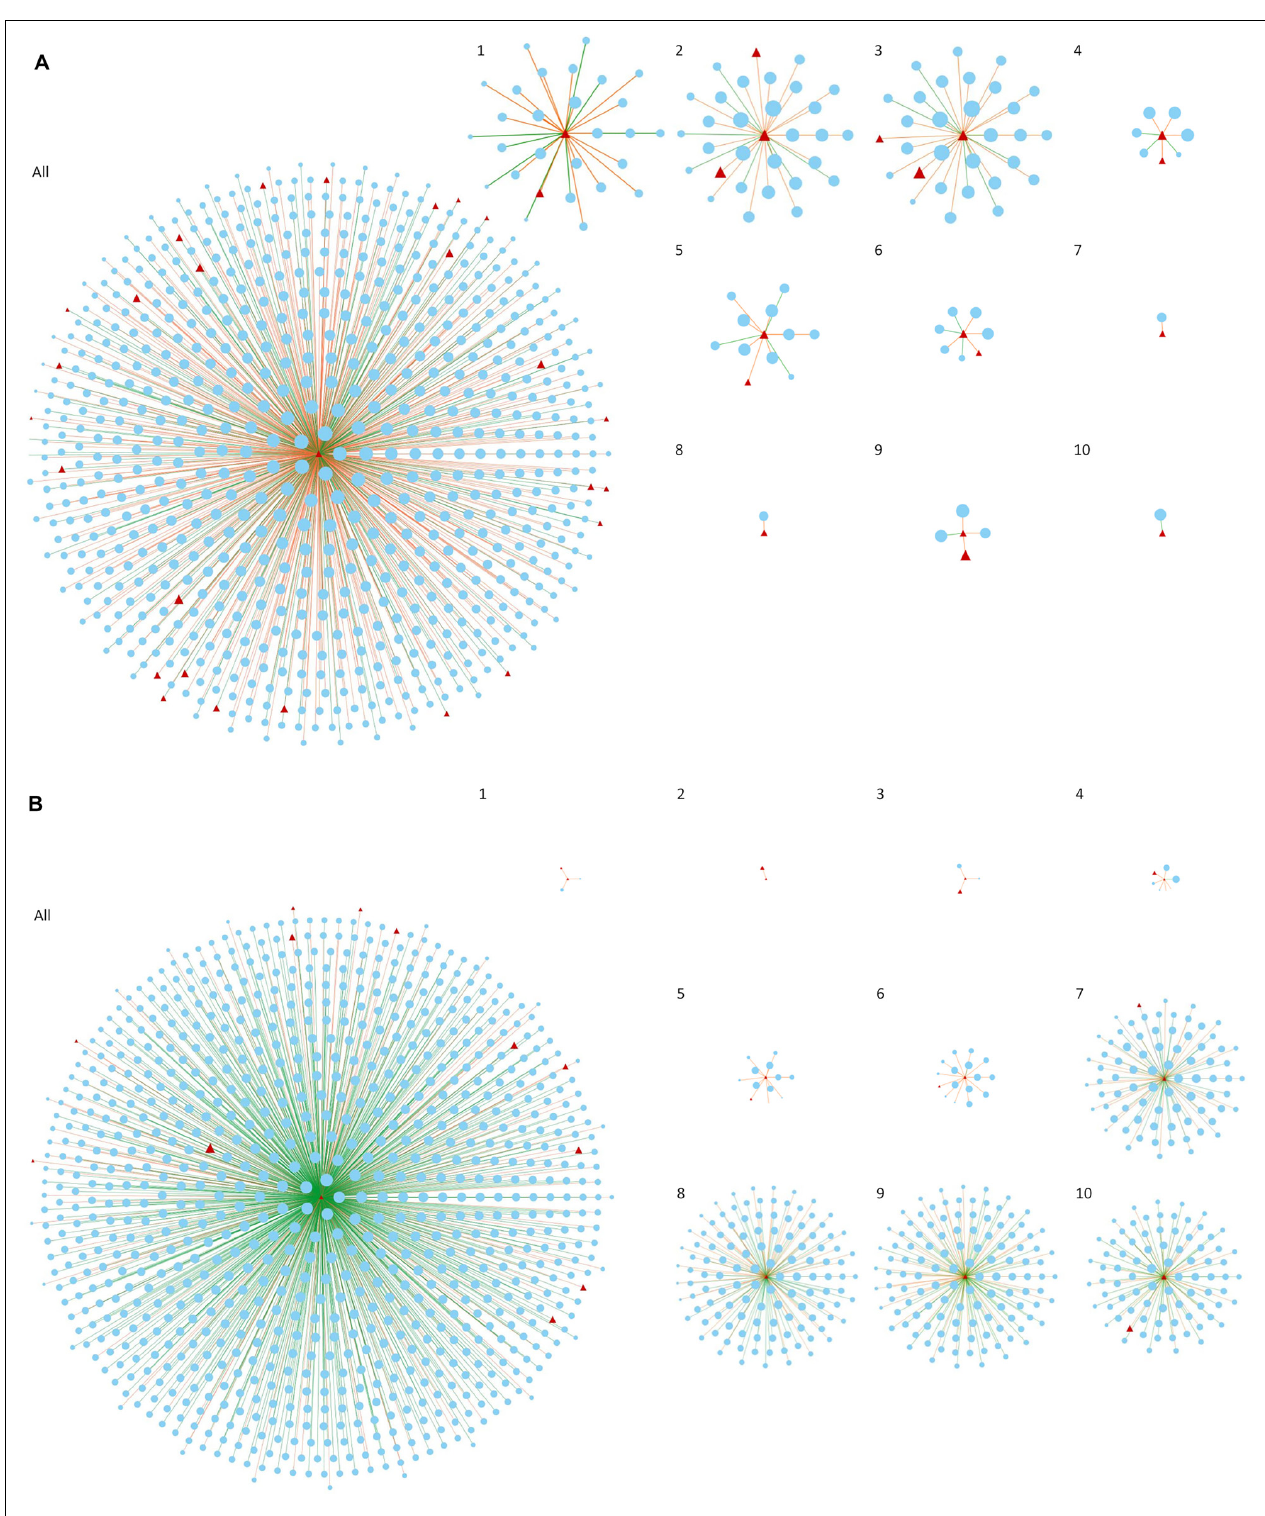
FIGURE 3 | Co-expression networks considering only the first neighbors (direct connections) of bcd (A) and Tusp (B) genes. The figure compares the result obtained creating one single network with all the time points of Drosophila embryogenesis (All) and the 10 networks constructed based on our dynamic approach (1–10). Red triangles represent key regulators and blue ellipses represent first neighbors of Tusp and bcd . Only connections appearing consistently in at least 3 networks and in less than 6 networks are reported for networks 1 to 10. Orange and green axis represent positive and negative correlations, respectively.